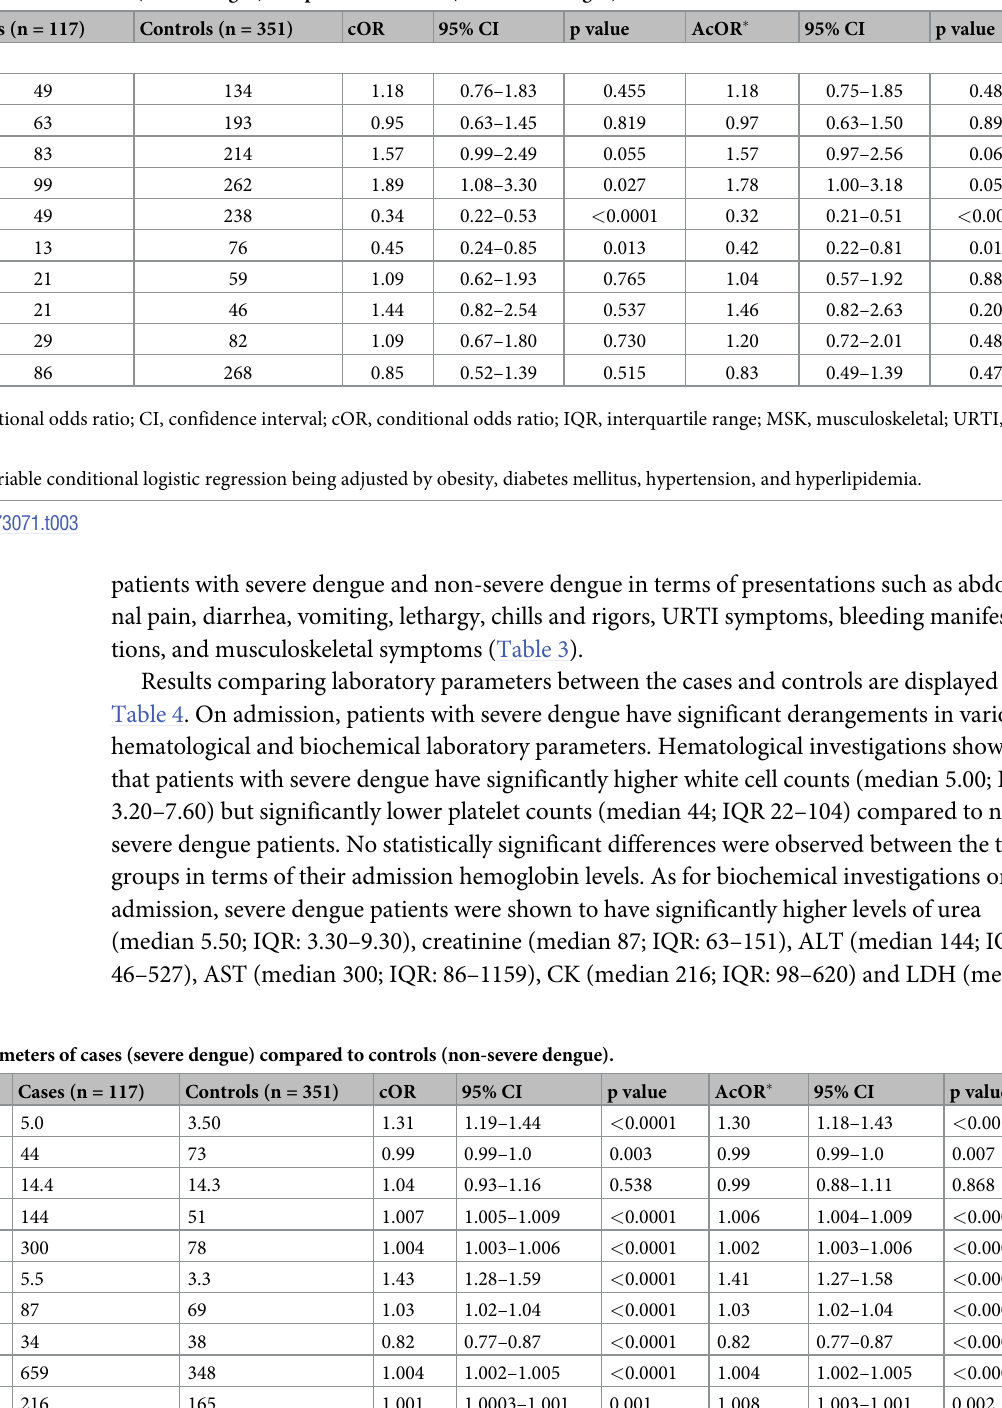
Table 3. Clinical presentation on admission of cases (severe dengue) compared to controls (non-severe